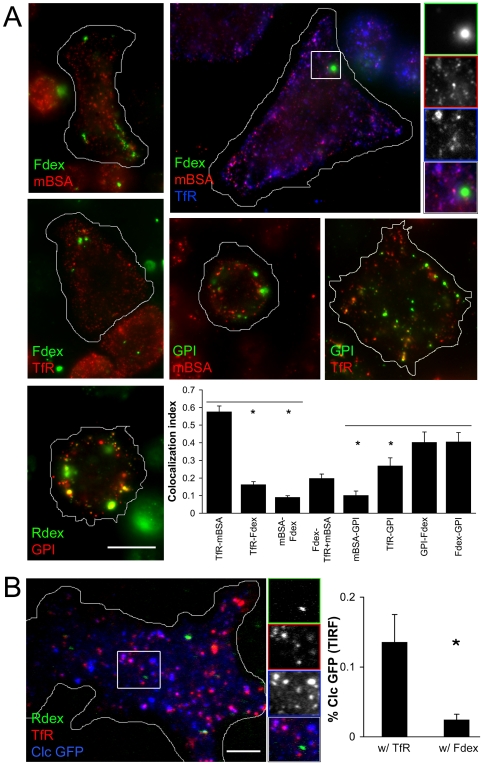
Fluid phase and GFP GPI probes mark a distinct endocytic route at early time points in S2R+ cells.(A) FITC- or TMR- dextran (Fdex, Rdex respectively) was pulsed along with: malelyated BSA or A568/A647 TfR (mBSA, TfR respectively); or αGFP (to mark internalized GFP GPI) for 30–60 s. Cells were fixed and imaged with wide field microscope at high resolution. Colocalization of different probes in combination with each other was then quantified. Bar graph represents mean±s.e.m. from at least 3 independent experiments with 20–50 cells for each probe combination in each experiment. (B) Rdex was co-pulsed with A647Tf for 30 s in cells expressing Clathrin light chain GFP (Clc GFP) which were fixed and imaged with TIRF microscopy. Bar graph represents the mean±s.e.m. percentage of Clc GFP spots that colocalized with TfR and Rdex endosomes (measured from >600 endsomes of each type from 13 cells). Asterix on all bar graphs mark the comparison population mean value and refer to those means that are significantly different from controls (P<0.05 by Student's t-test). The outline in white was traced using the phase contrast image of the cells obtained in bright field. Bars in A = 5 µm, B = 2 µm, insets magnified 2x.